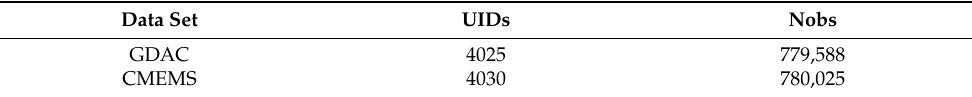
Table 5. The number of Argo UIDs and observations in Coriolis GDAC and CMEMS.